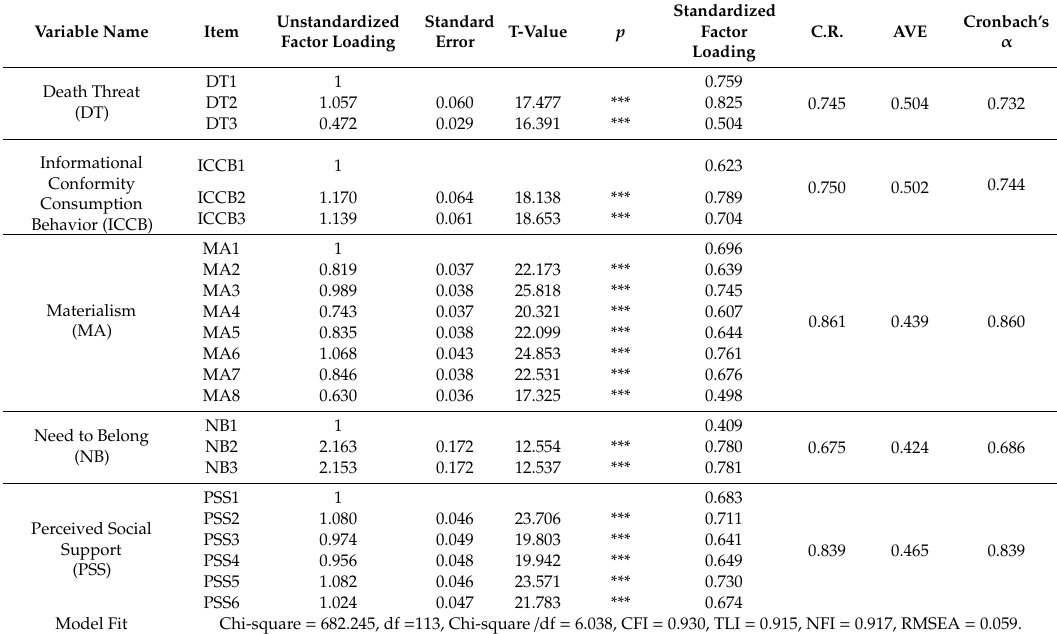
Table 1. Reliability and Validity Analysis ( N = 1453).